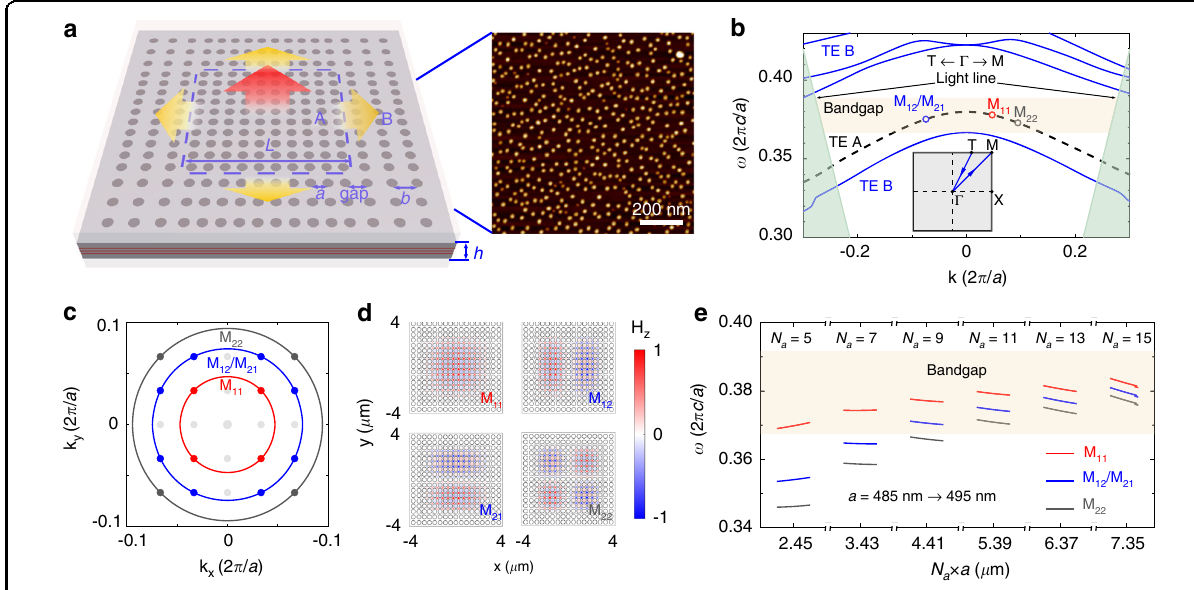
Fig. 1 The theoretical scheme of mini-BIC laser structure. a Schematic of a mini-BIC cavity (region A) encircled by a boundary of photonic bandgap (region B) to form a photonic heterostructure. The cavity region A is a N a × N a array of square latticed circular holes with the period of a and side-length of L , while the boundary region B is an array with a width of N b and a period of b , but shares the same period of a in the connecting side with region A. The circular holes of the PhC slab, whose radii are equal to r , are etched in an InAs/GaAs QD active layer with thickness h = 556 nm. The PhC slab is designed to be immersed in NOA. An atomic force microscopy (AFM) image of uncapped InAs/GaAs QDs (the right panel) indicates QD density of 5.5 × 10 10 cm − 2 . b The calculated band diagrams of in fi nite PhC slabs: the continuous band (TE A, represented by the black dashed line) of an in fi nitely large PhC splits into a series of discrete modes above the light line and located in the bandgap of region B (TE B, represented by the blue solid line). c The momentum distribution of each mode, labeled as M pq according to their location in the fi rst quadrant of momentum space. d Calculated H z near- fi eld distributions of M 11 , M 12 , M 21 and M 22 at a = 495 nm in a fi nite-size cavity with N a = 13. e Simulated mode frequencies of mini-BIC structures with N a varying from 15 to 5 and the lattice constant varying from 495 to 485 nm. The mode intervals increase with decreasing N a and only one mode of M 11 settles inside the bandgap when N a deceases to 7, indicating that single-mode lasing may be realized in a small cavity with N a = 5 or